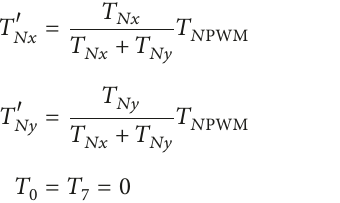
Table 5: The relations between vector dwelling time and its sector. sector